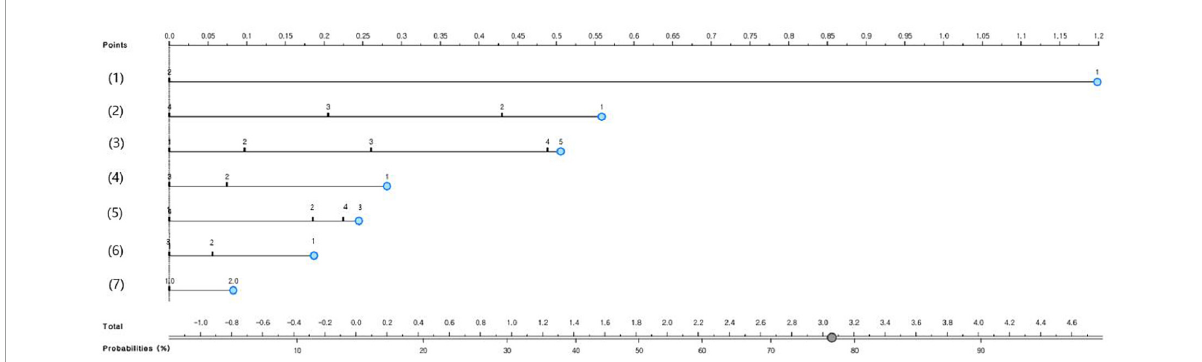
FIGURE2 The nomogram to predict groups vulnerable to obesity in South Korean adolescents; (1) Gender (1 = male or 2 = female), (2) number of days of conducting strength training in the past seven days (1 = none, 2 = 1–2 days, 3 = 3–4 days, or 4 = 5 days or more), (3) academic performance (1 = high, 2 = medium-high, 3 = medium, 4 = medium-low), (4) stress perception level (1 = high, 2 = moderate, or 3 = low), (5) the number of days of drinking soda in the past seven days (1 = none, 2 = 1–2 days, 3 = 3–4 days, or 4 = 5 days or more), (6) the number of days of conducting the moderate-intensity physical activity for 60 min or more per day in the past seven days (1 = none, 2 = 1–2 days, or 3 = 3 days and more), and (7) mean sitting hours per day (1 = less than 6 h or 2 = 6 h or more).